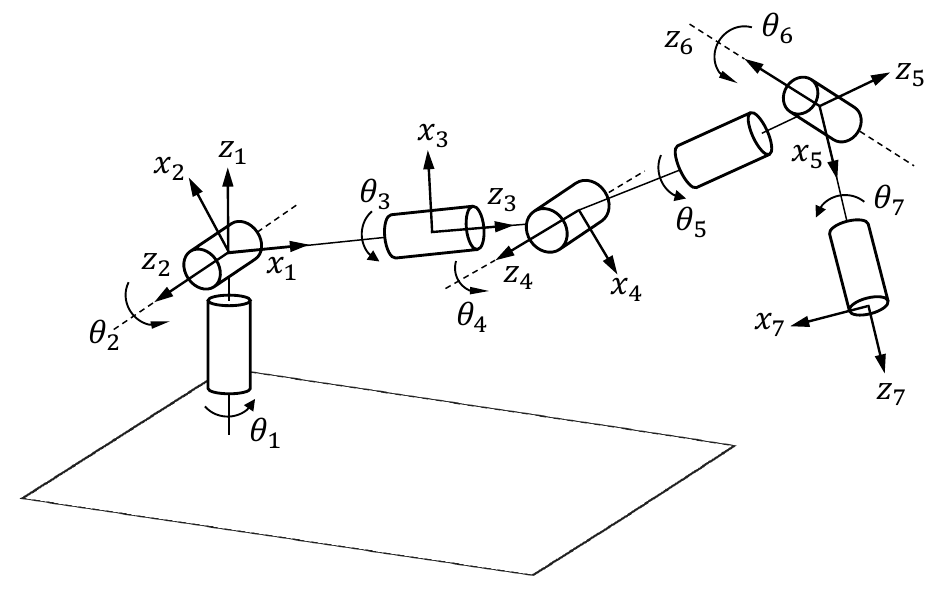
Figure 4. Schematic representation of the Kuka LWR